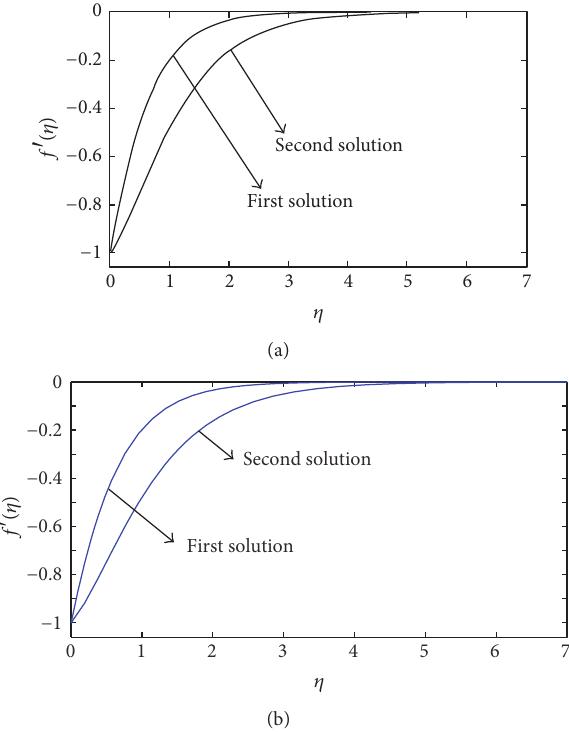
Figure 14: A comparison of velocity profiles for Newtonian fluid ( 𝛽 → ∞ ) with 𝑆 = 2.4 between (a) Bhattacharyya [26] and (b) present